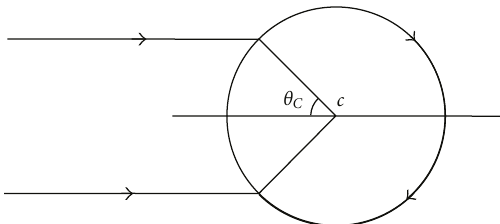
Figure 2: Test tank setup. Cable responses can be measured in free water or against a sediment background. A pan-and-tilt unit is used to rotate the cable section for multiaspect experiments.